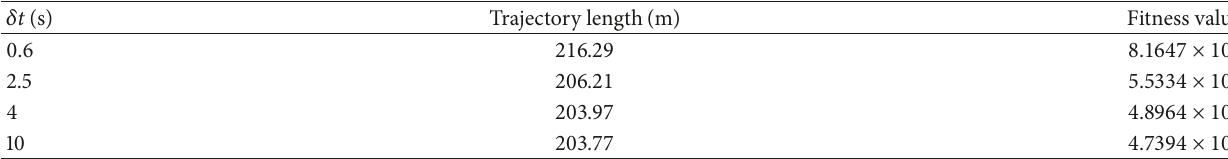
Table 11: Comparison results of trajectory length and fitness value.